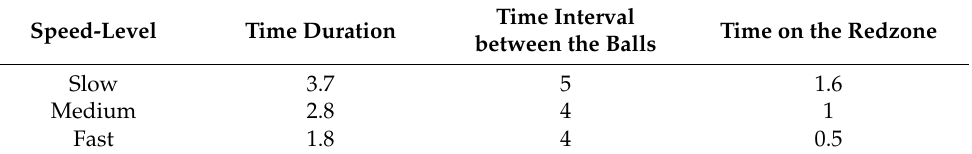
Table 2. Time difference based on the speed of the hit-the-ball game (in seconds).